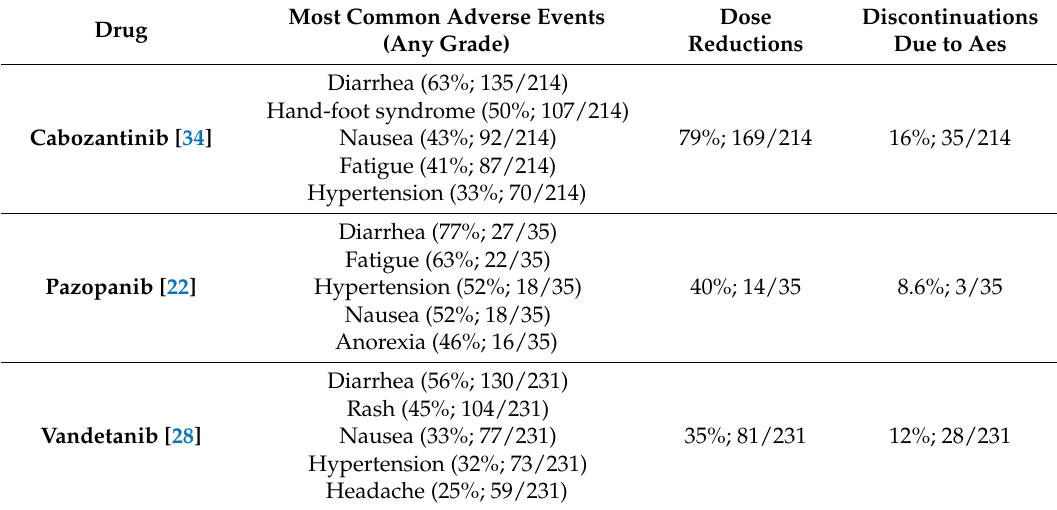
Table 2. Adverse effects during tyrosine kinase inhibitor (TKI)-therapy of progressive medullary thyroid cancer